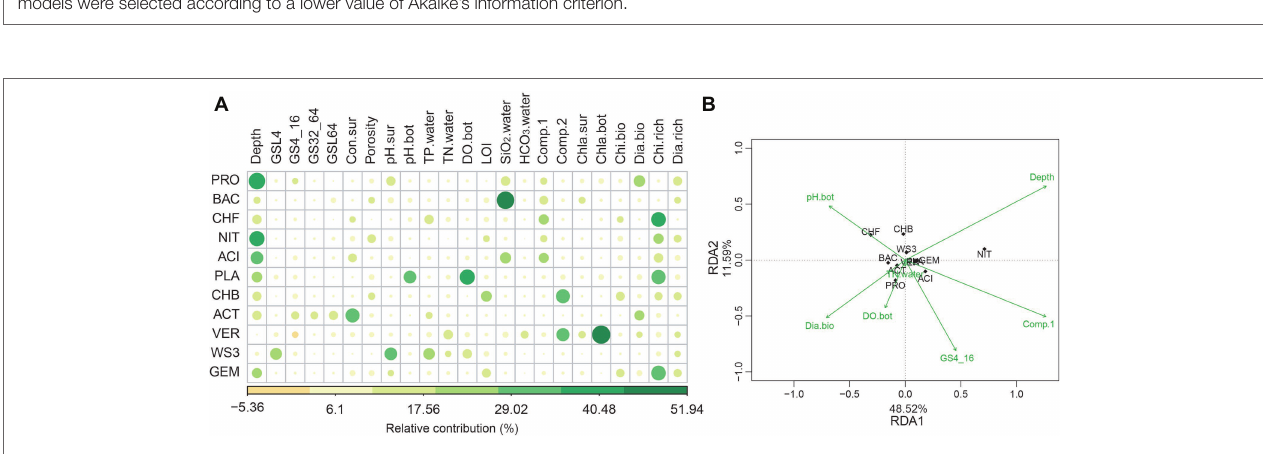
FIGURE 2 | The relationship of niche position between the phylum and species levels (A) , and the relationships between the occupancy and abundance of each phylum (B) . The shapes in (A) represent various distributional patterns: ■ , hump-shaped pattern; ● , decreasing pattern; ▲ , increasing pattern; ♦ , U-shaped pattern. (B) Relationships between occupancy and mean local abundance for bacterial phyla. The points in (B) represent the different species. Linear or quadratic models were selected according to a lower value of Akaike’s information criterion.